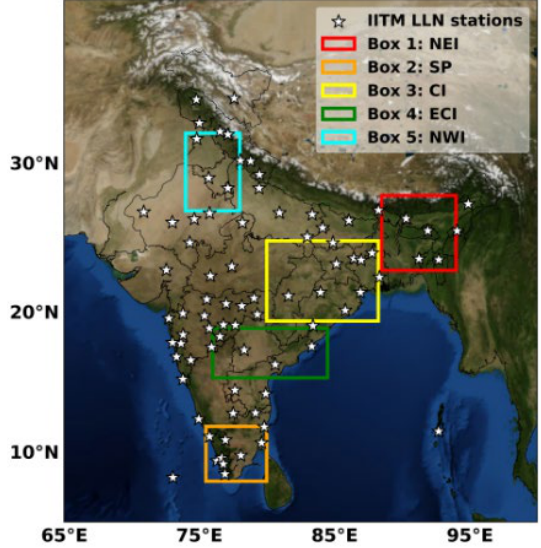
Figure 1. The locations of Indian Institute of Tropical Meteorology (IITM) Lightning Location Network (LLN) stations (marked by white stars). Overlaid colored boxes are 5 thunderstorm-prone regions (as defined by [26]).